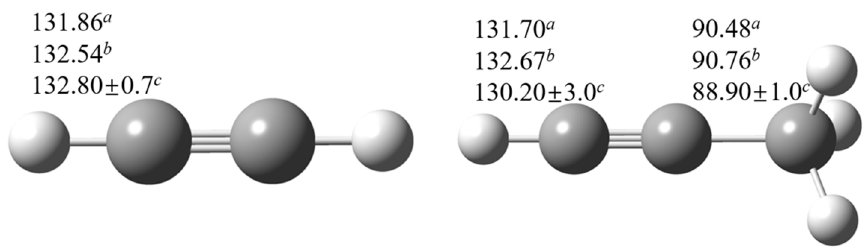
Figure 5. Computed BDEs (in kcal mol − 1 ) for C-H bond in acetylene and propyne. aW1BD method, bCCSD(T)/CBS method, cRecommended value from Luo [6].